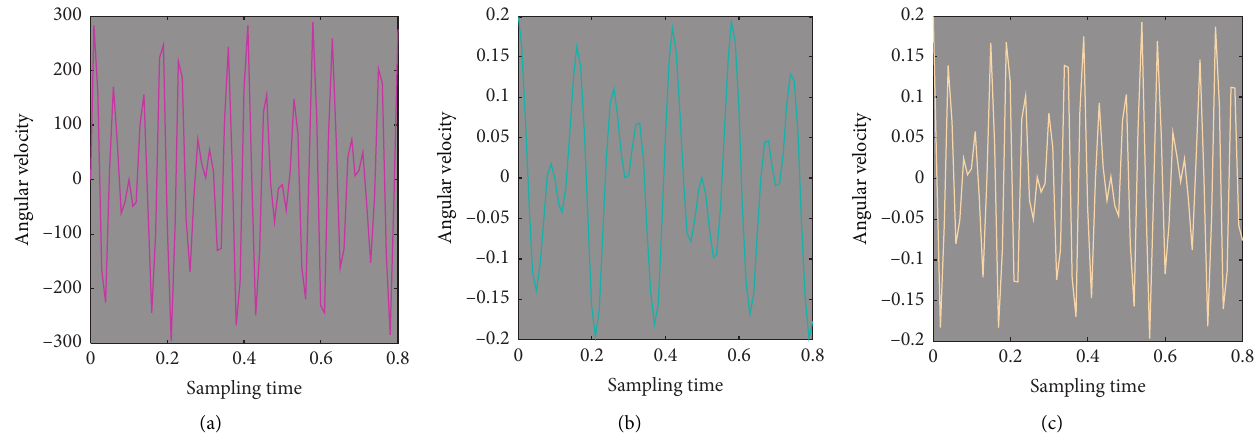
Figure 10: Action angular velocity data of (a) X -axis, (b) Y -axis, and (c) Z